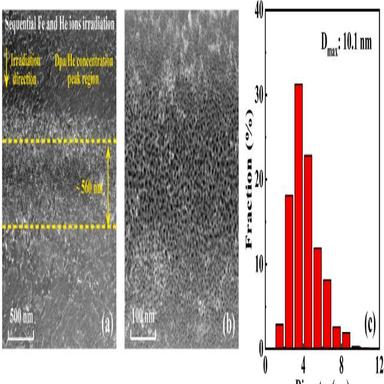
Cross-sectional TEM images of Dpa/He concentration peak region at different magnifications for Cu sample irradiated by Fe ions first, followed by He ions.